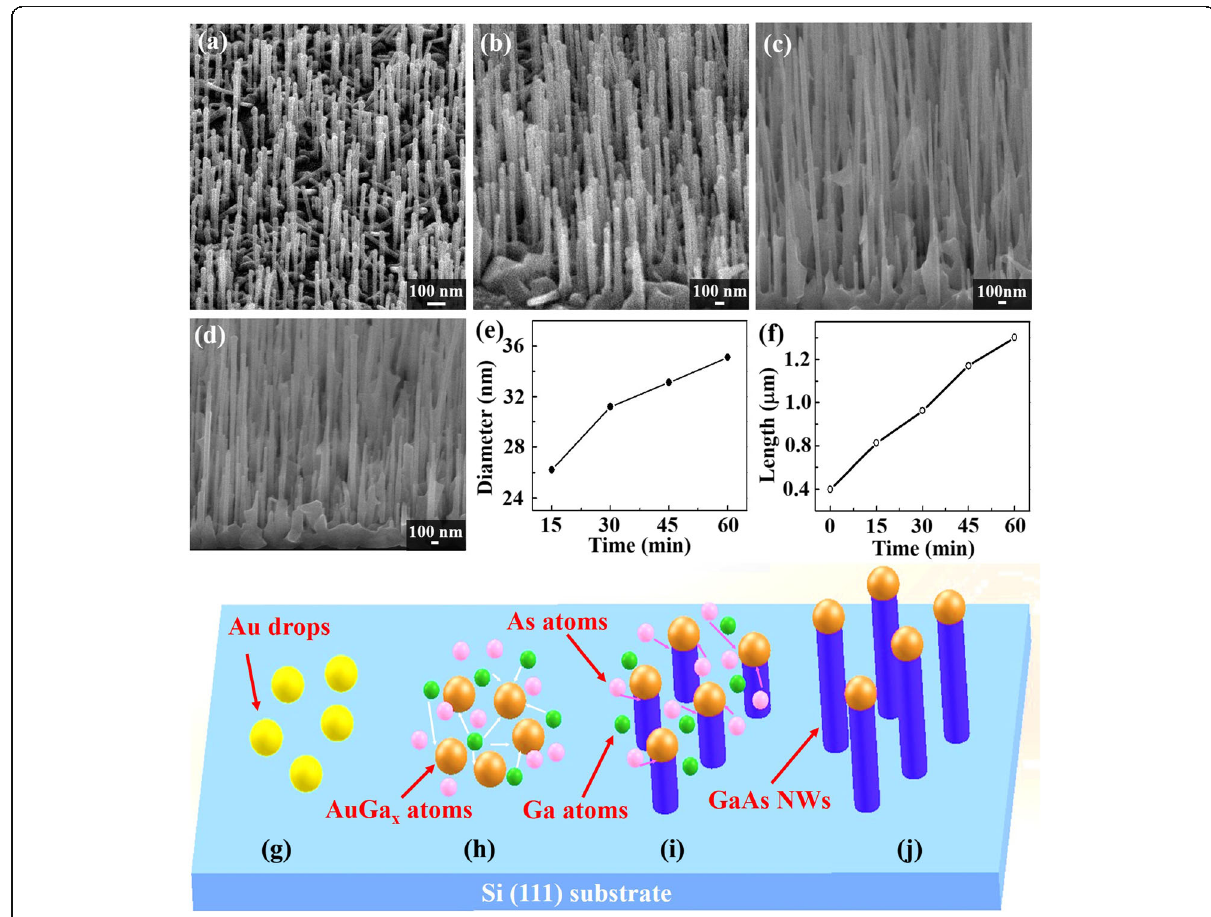
Fig. 3 SEM, diameter-time, length-time, and growth mechanism. SEM images show the length and diameter of GaAs NWs with varied growth time, for ( a ) 15, ( b ) 30, ( c ) 45, and ( d ) 60 min. e, f Varied growth time vs the relationship of diameter and growth length, respectively. g – j The schematics illustrating the growth of Au-catalyzed GaAs NWs : g the Au film annealed to form Au drops, h Au drops alloy with Ga to produce the AuGa x alloy catalyst, and i the segregation of Ga out of the AuGa x catalyst can be achieved as the AuGa x alloy catalyst reaches a supersaturation condition. j Form the axial growth of GaAs